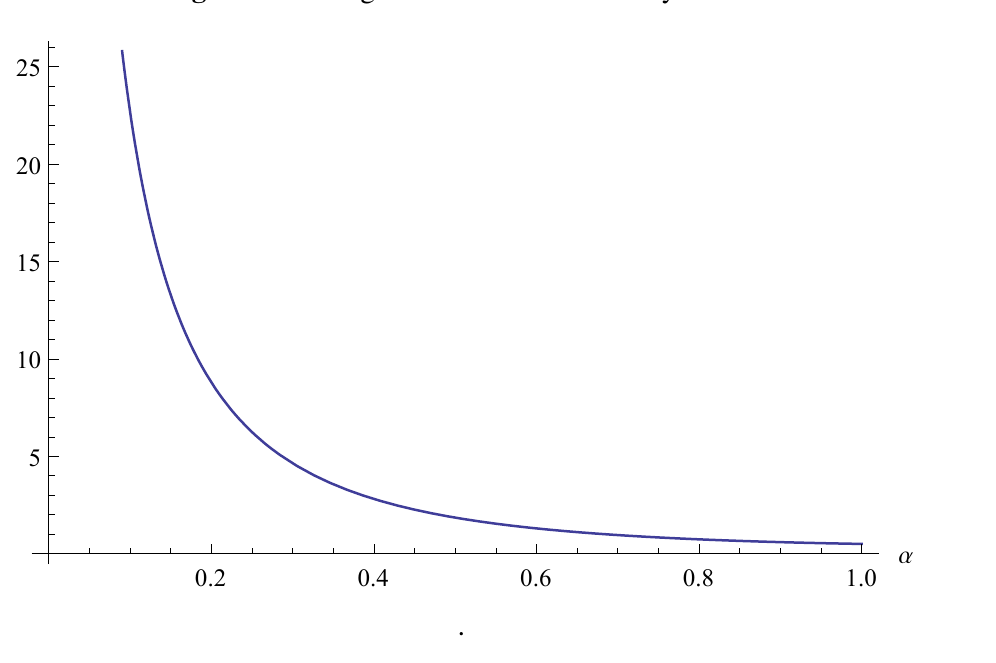
Figure 1. The right-hand side of Corollary 3 vs .